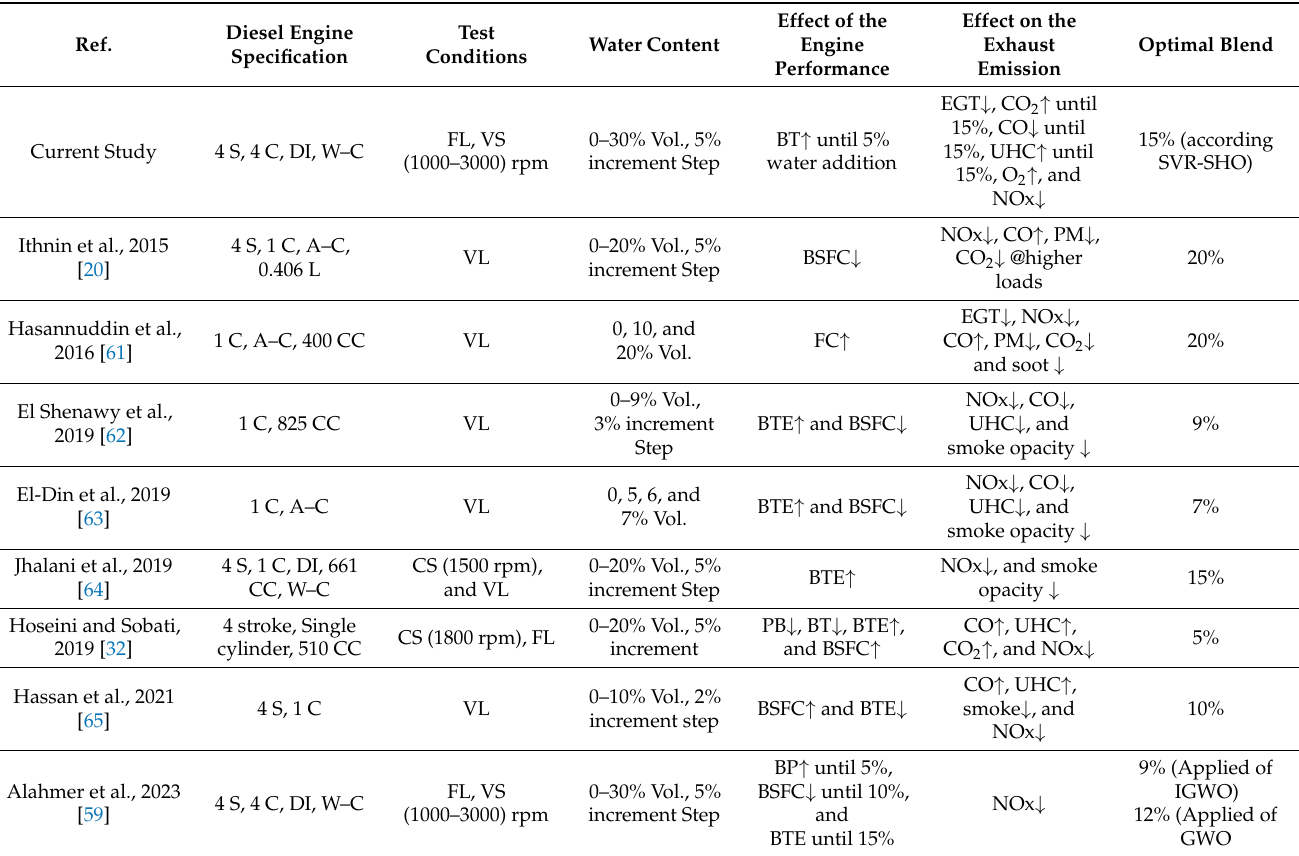
Table 11. Compare the present study with other studies that utilized W/D emulsions in diesel